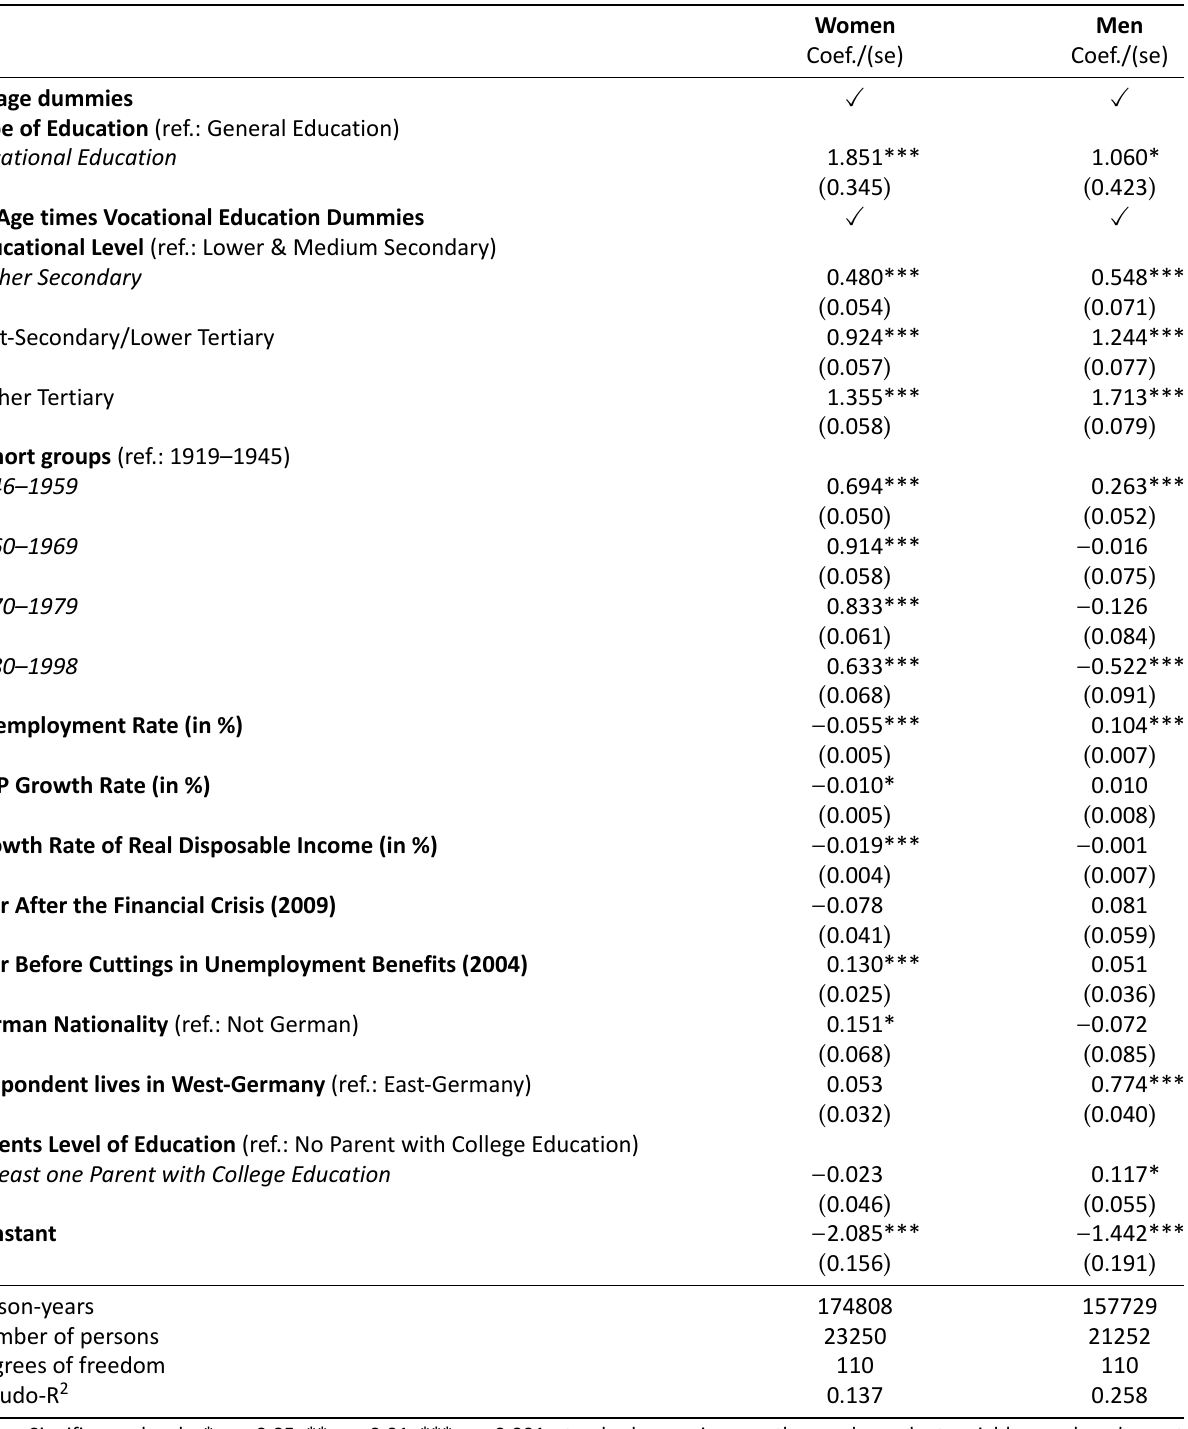
Table A4. Employment opportunity over the life course: General versus vocational education by gender. Data source: GSOEP (n.d.).